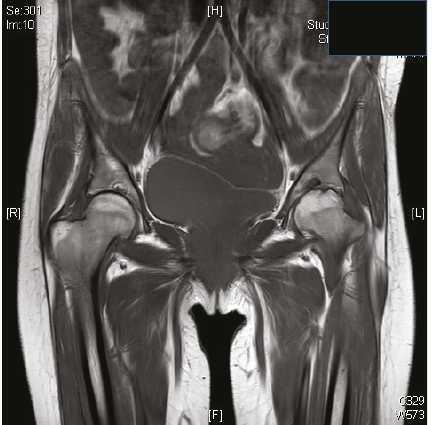
Figure 3: MRI of the hip at age 19. Appearances are in keeping with in fl ammatory arthropathy.